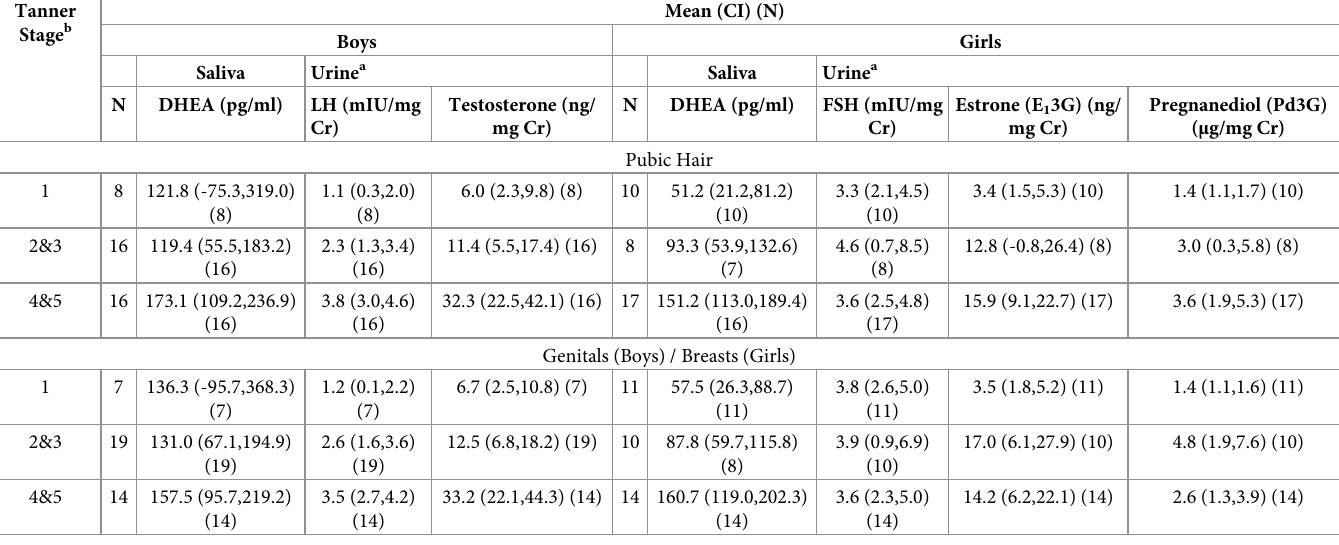
Table 3. Mean endocrine marker concentrations at visit 3 by Tanner